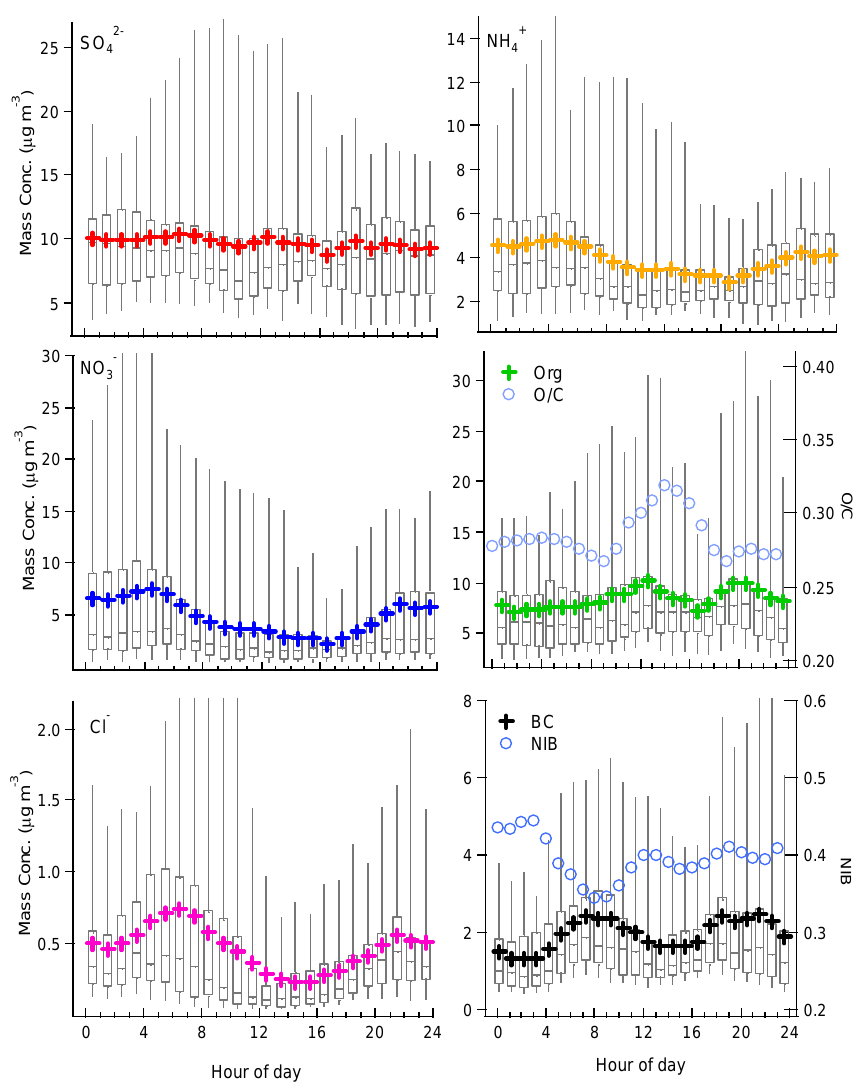
Fig. 3. Diurnal variation box plots of PM 1 species. The upper and lower boundaries of boxes indicate the 75th and 25th percentiles; the line within the box marks the median; the whiskers above and below boxes indicate the 90th and 10th percentiles; and cross symbols represent the means.